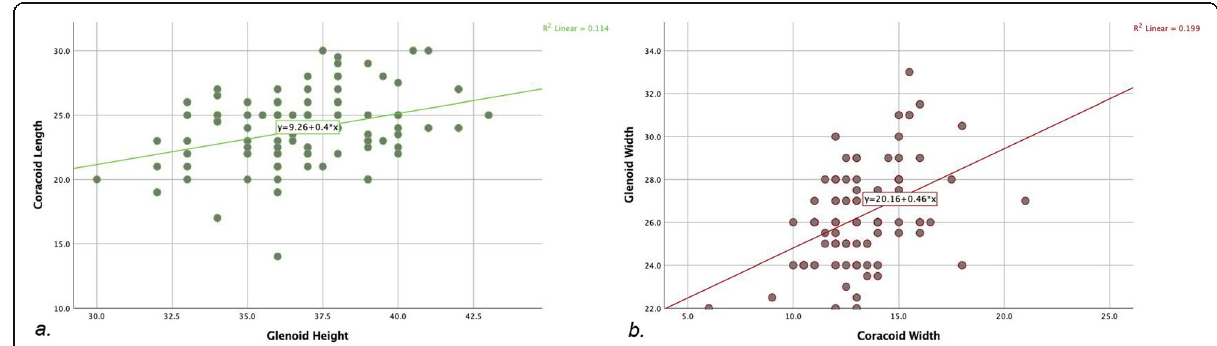
Fig. 6 A positive correlation was found between ( a ) the GH and the CL (rho = 0.3, p = 0.002) and ( b ) between the GW and the CW (rho = 0.45, p <